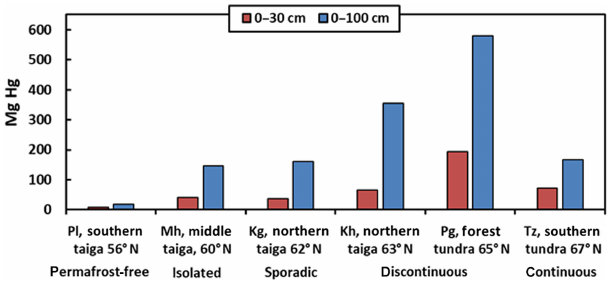
Figure 6. Total depth-integrated pools of Hg mass (Mg) in the upper 0–30 and 0–100cm (red and blue columns, respectively) of WSL frozen peatlands in each permafrost zone. The stocks are calculated assuming the areal proportion of bogs from the landscape inventory across the WSL (Sheng et al.,